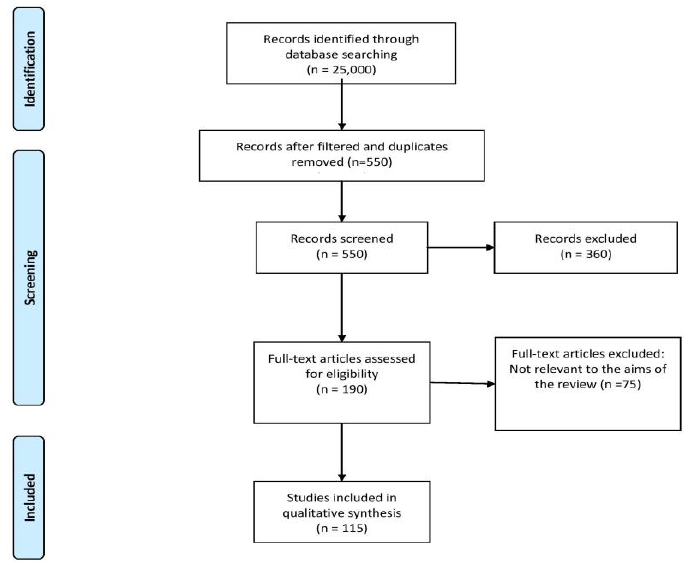
Figure 3. PRISMA- 2020 flow diagram for selection of studies.